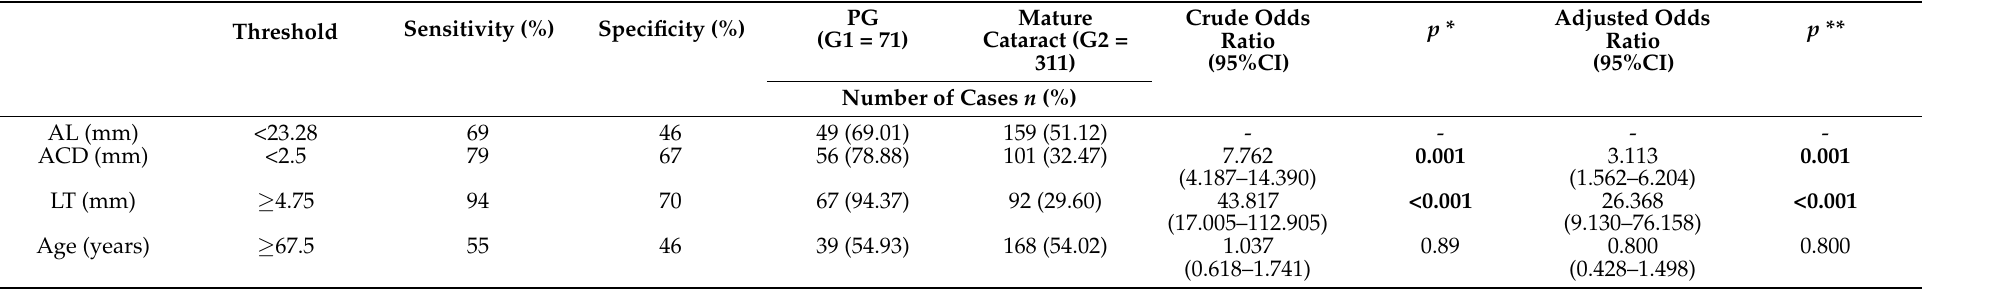
Table 3. The threshold values and results of logistic regression analysis of A-scan